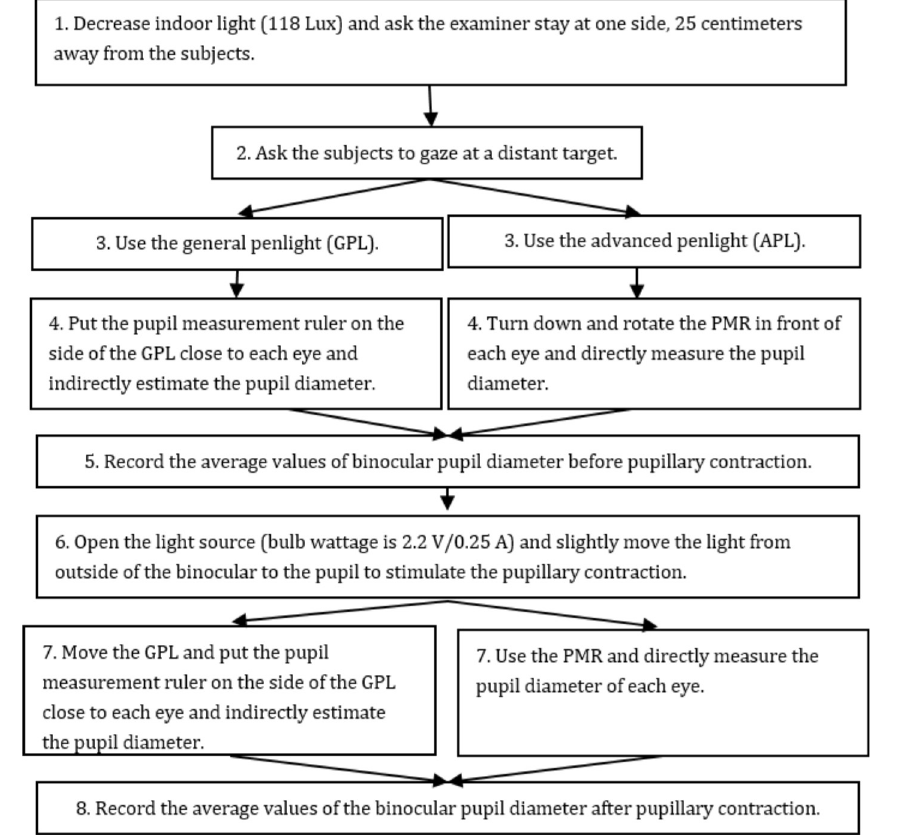
Fig 3. Eight steps of the standard procedures for the GPL and the